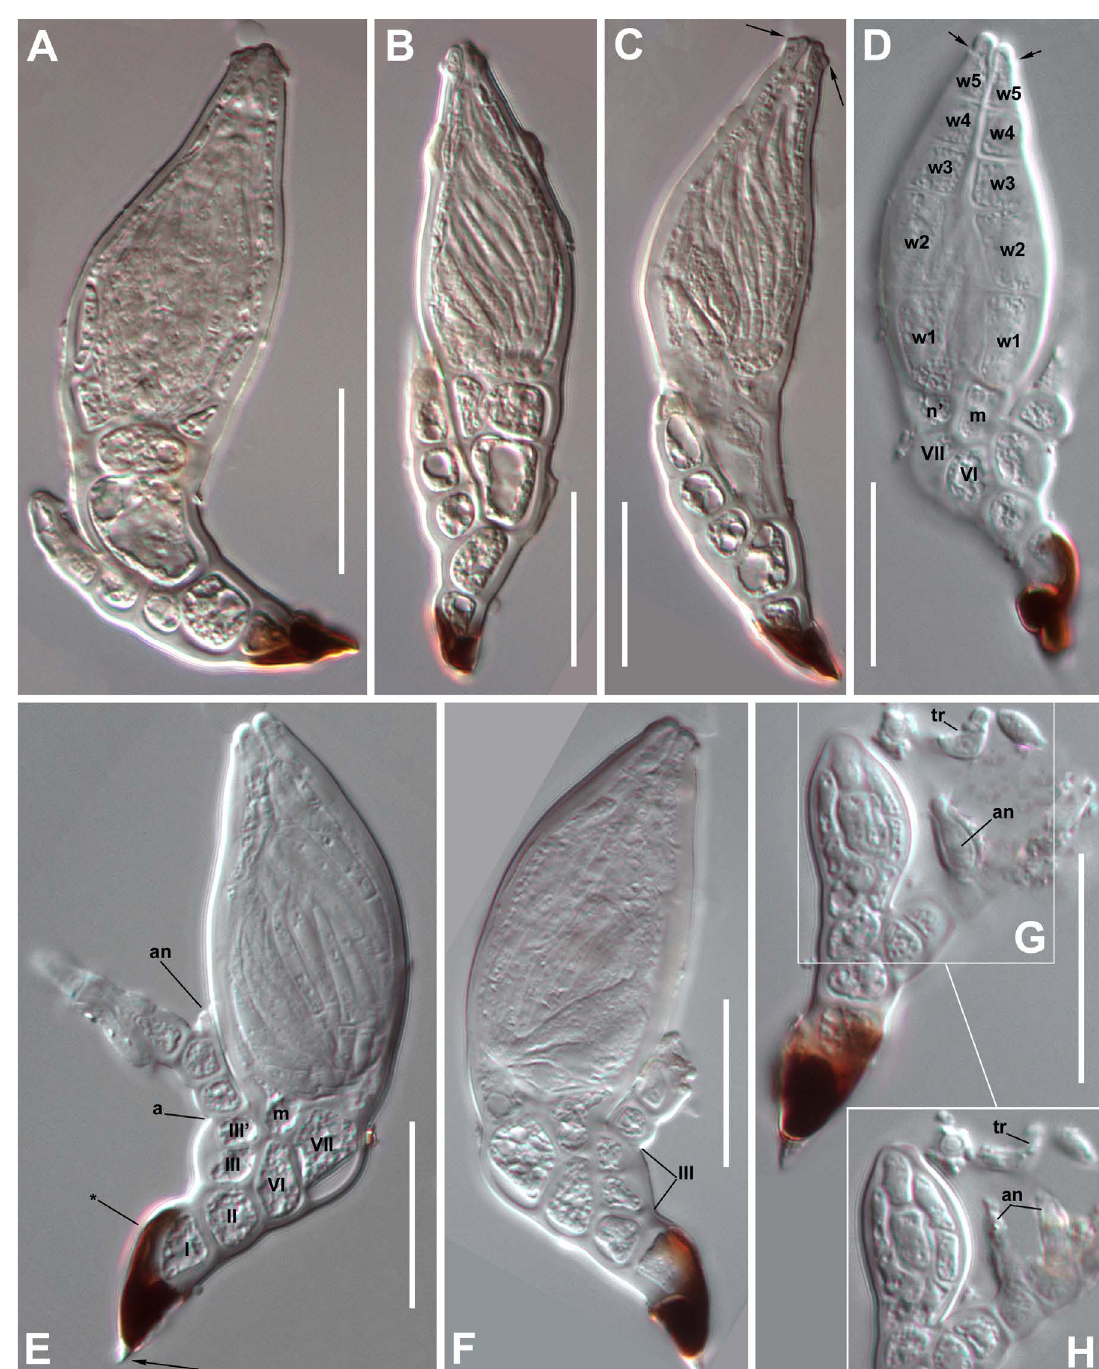
Fig. 49. Cryptandromyces spp. A – C . C. bryaxidis T.Majewski. Mature thalli. In C, arrows point to small teeth below the conical perithecial tip. – D – H . C. cryptophagi Santam. sp. nov. D . Mature thallus with labelled cells VI, VII, m, n’, and two vertical rows of perithecial wall cells (w ); arrows point to the scar n through which the lips emerge. E . Mature thallus with labelling of cells I, II, III, III’, VI, VII, m, primary septum (a), and antheridium (an); arrow points to the acute hyaline beak at the base of foot, * points to dark brown stripe on cell I. F . Mature thallus showing cell III. G – H . Immature thalli in detail at two focus levels to show antheridia (an), and trichogyne (tr). Scale bars: 20 µm. Photographs from slides ZMUC C-F-123224 (A–C), ZMUC C-F-123532 (D–H)